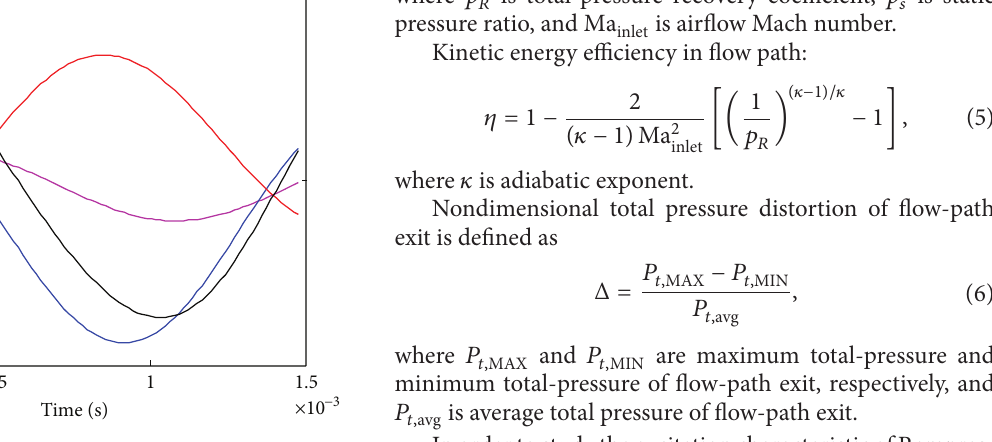
size 45,439 shows a good agreement with that of the grid size 84,590 (Figure